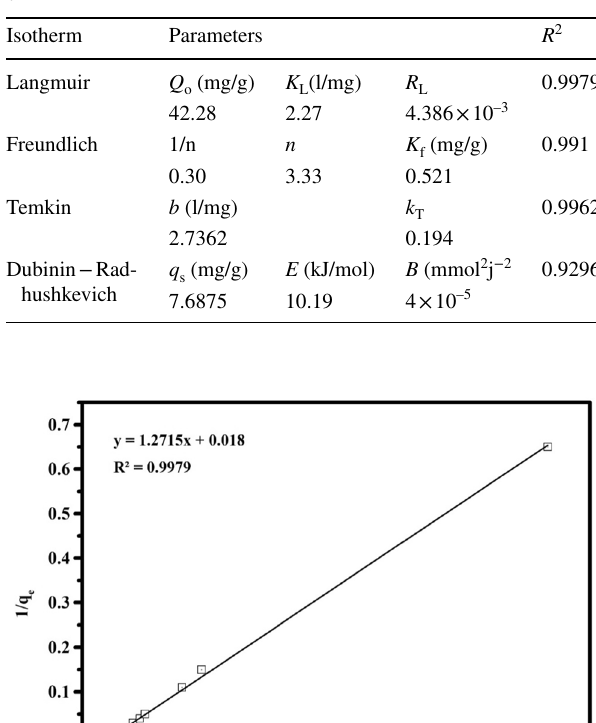
Table 4 Various adsorption isotherm parameters of MB dye adsorbed